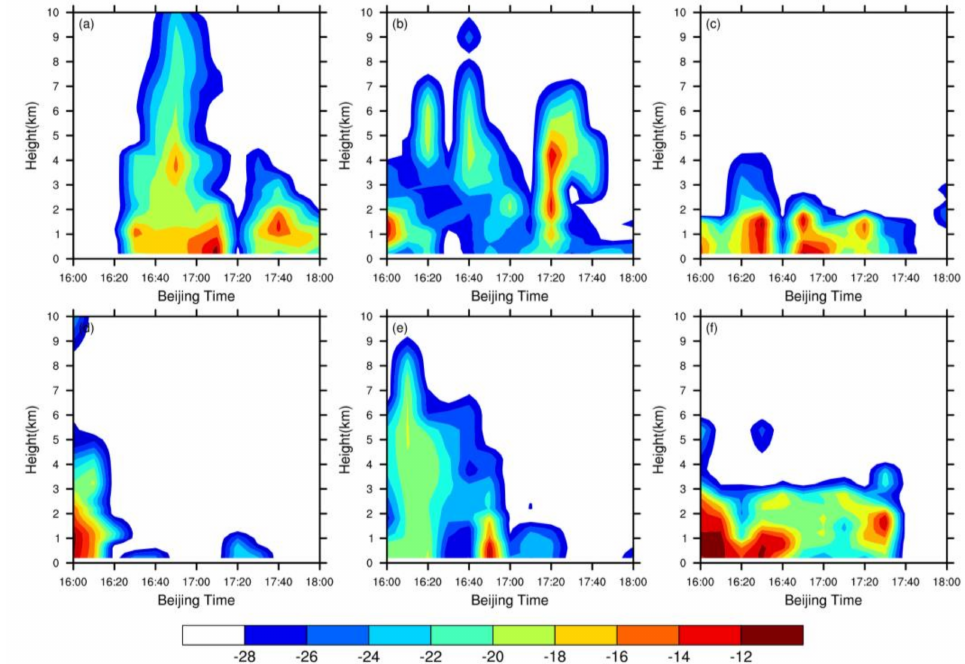
Figure 5. The simulated reflectivity factors ( a – f ) were for Lin, WSM5, WSM6, New Thompson, Morrison, and Eta, respectively (unit: dbz). This figure is obtained by the regional averaging of the black dashed area (32.5–33.5 ◦ E, 96.5–97.5 ◦ N) in Figure